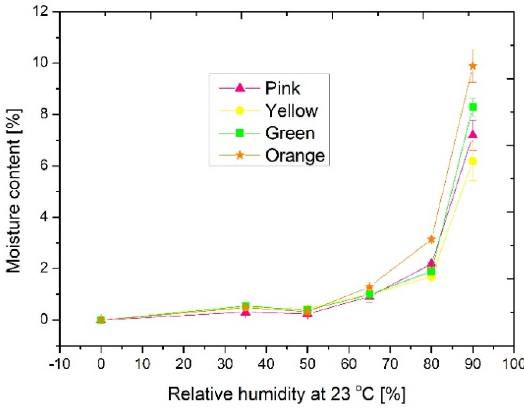
Figure 7. Sorption isotherms.